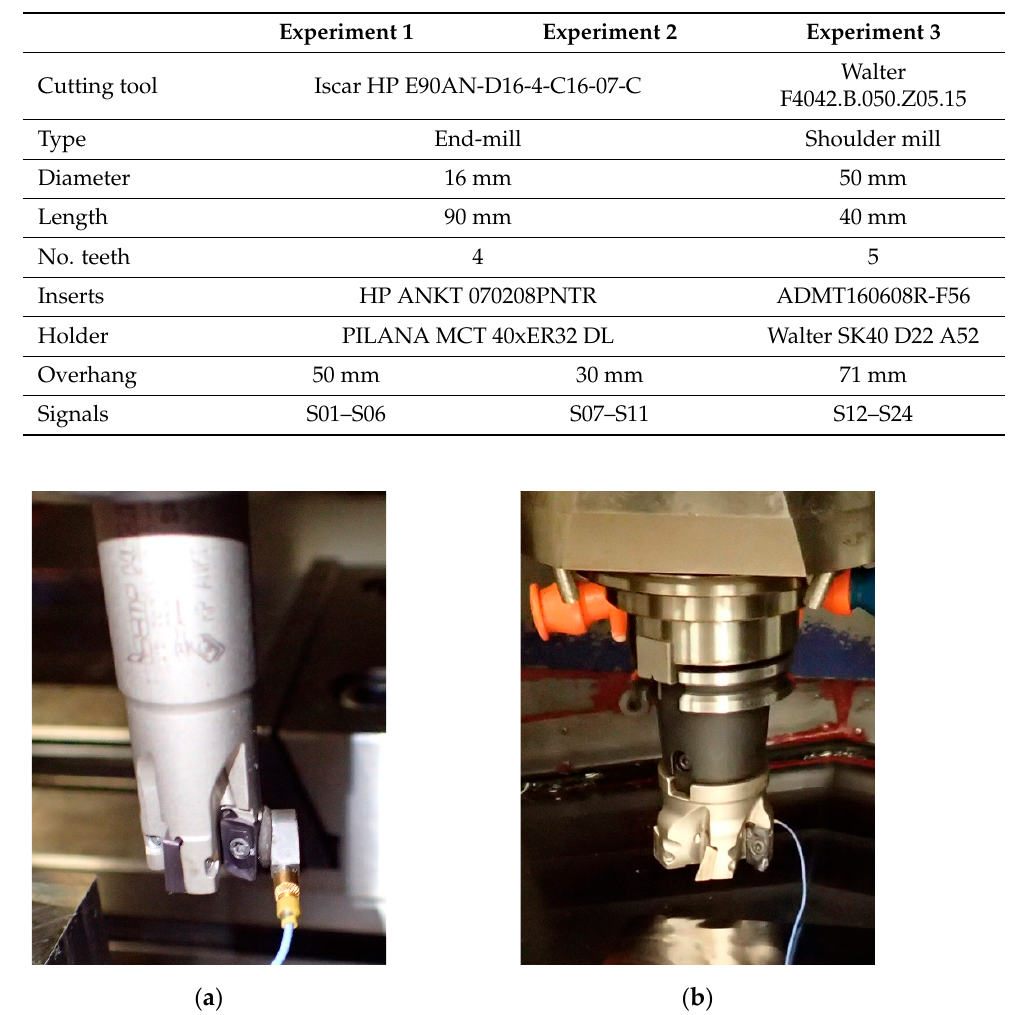
Table 1. Summary of performed experiments.